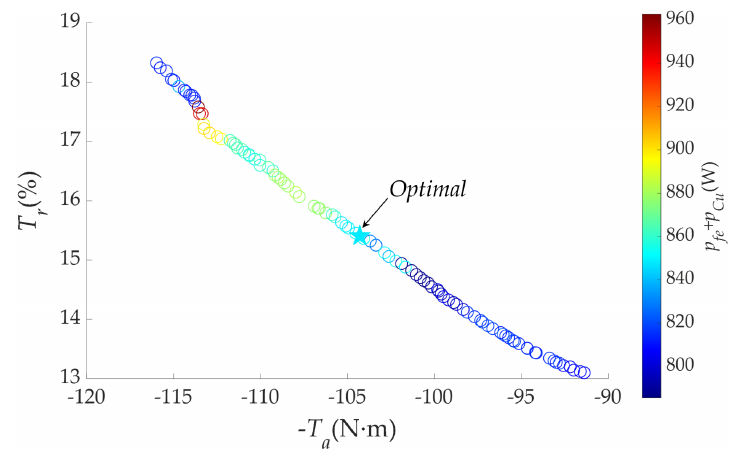
Figure 7. Pareto solution after NSGA − II optimization. Table 5. Optimal candidate solutions.